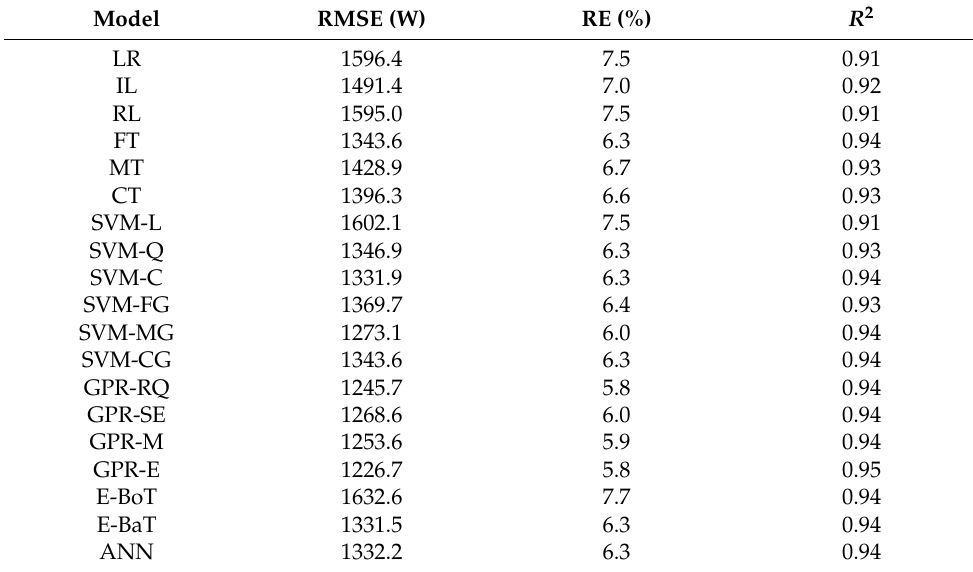
Table 5. Main statistical results for machine learning using testing